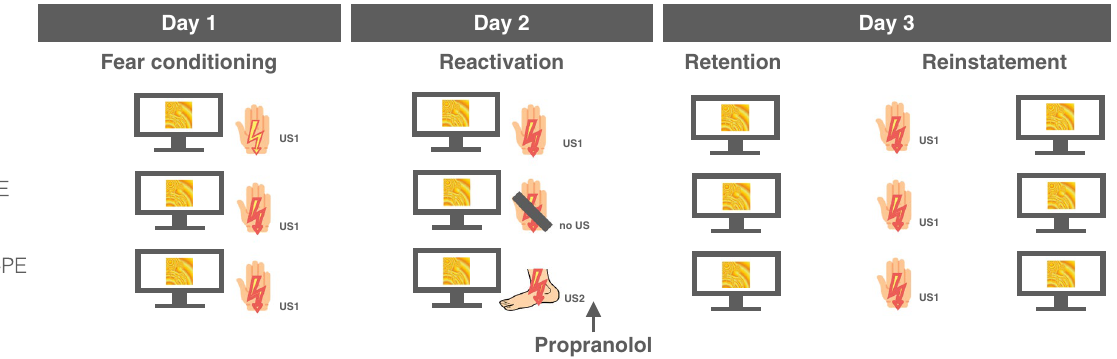
Figure 1. Experimental design. All groups underwent fear conditioning on day 1 during which a visual stimulus (CS+) was reinforced with an electric stimulus to either wrist or ankle (US1), whereas another CS (CS−) was never paired with the US (not shown). During memory reactivation on day 2, the ‘no PE’ or control group was presented with the same CS+ US1 pairing again. The US1 was omitted in the value-PE group eliciting both a model-free and model-based prediction error. In the identity-PE group the CS+ was paired with an electric stimulus to the respective other location (US2) eliciting a model-based identity, but no model- free PE. Subsequently, all groups received 40 mg propranolol HCl. We tested the effect of this reconsolidation intervention with different PE manipulations on fear potentiated startle responses during retention and after reinstatement on day